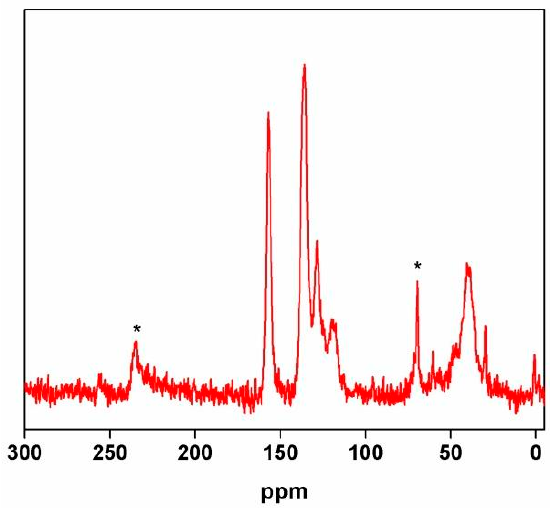
Figure 8. The 13 C CP-MAS NMR of PU NCs (PU-15); * indicates the spinning sideband.